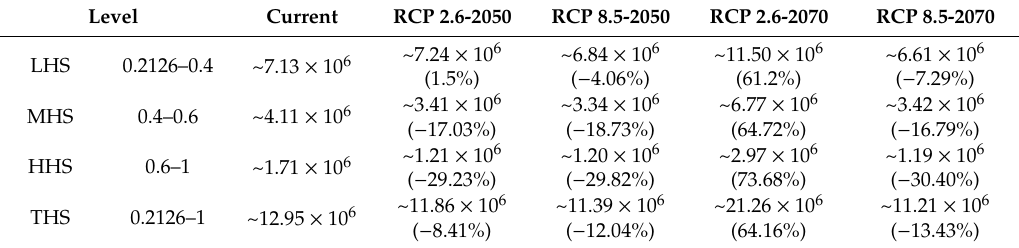
Figure 2. The potential distribution of Phenacoccus madeirensis Green used in the current modeling. Gray, unsuitable habitat area; blue, low habitat suitability area; yellow, moderate habitat suitability area; red, highly habitat suitability area. Table 2. Predicted suitable areas for two invasive species under current and future climatic conditions (km 2 ).